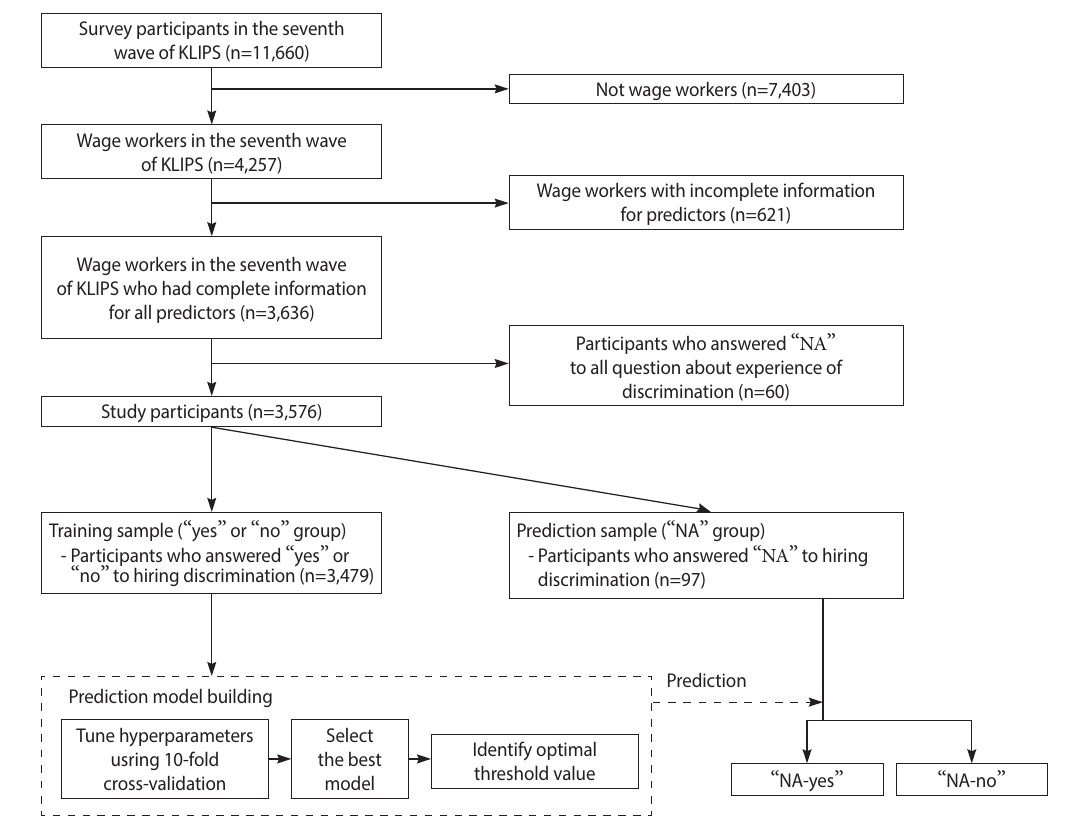
Figure 1. Flow chart of data analysis. KLIPS, Korea Labor and Income Panel Study; NA, not